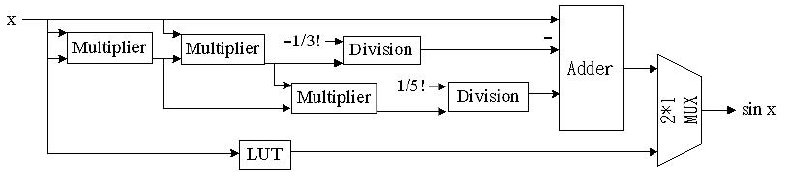
Figure 15. Block diagram of the sine function with the Taylor expansion and LUT.